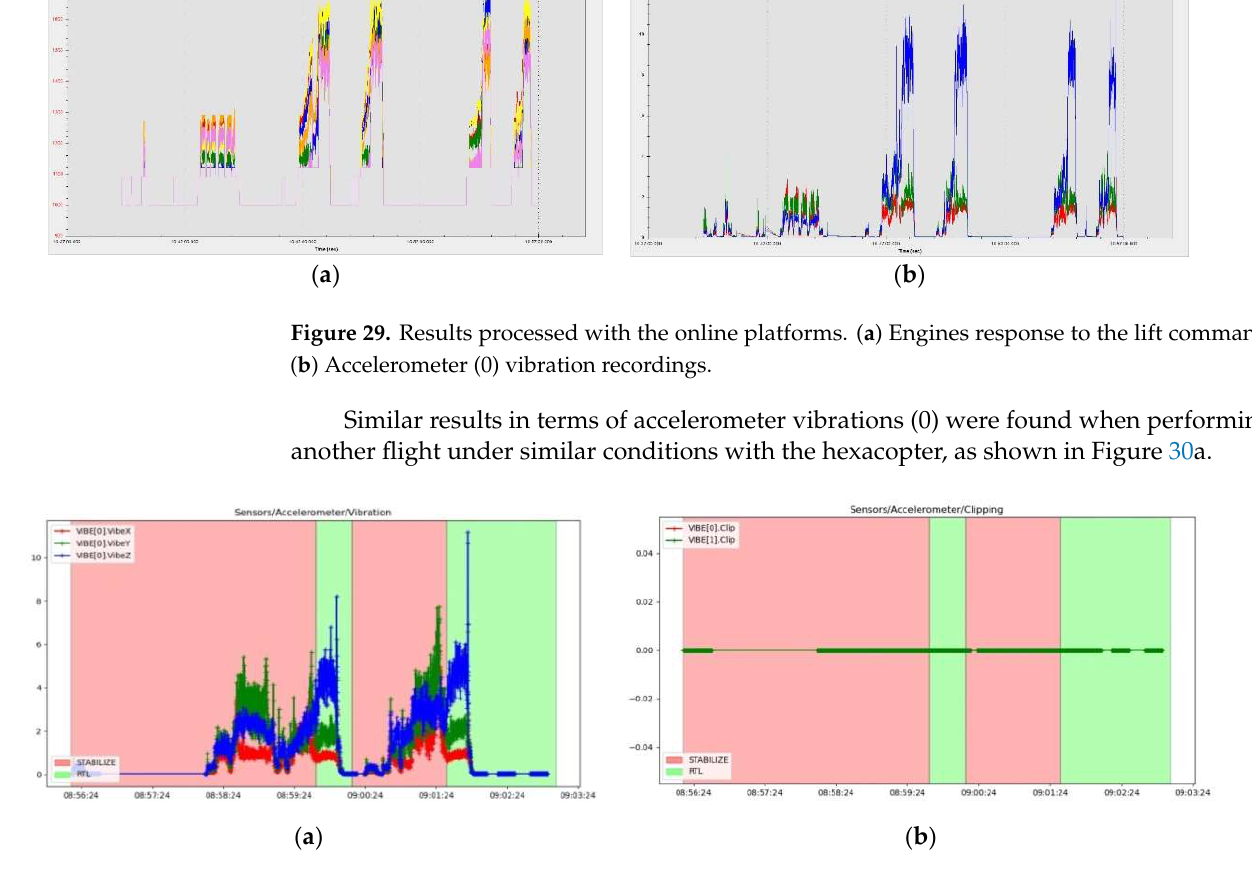
Figure 29. R esults processed with the online platforms. ( a ) Engines response to the lift command; ( b ) Accelerometer (0) vibration recordings.